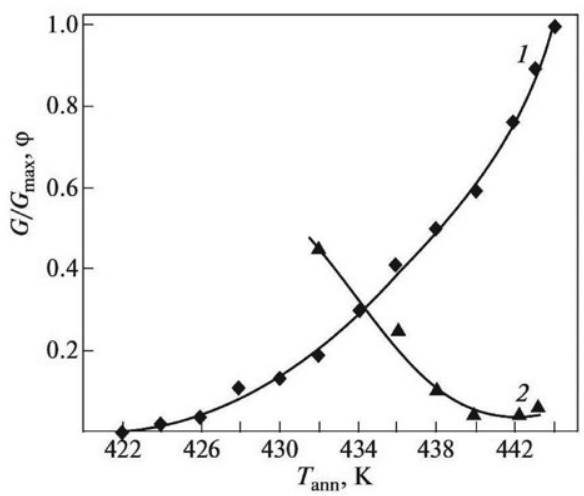
Figure 7. The dependences of the ratio G/G of porous films (1) and the parameter ϕ (2) on the temperature T